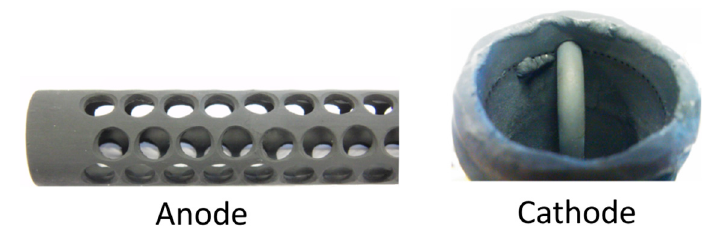
Figure 8. View of the anode and cathode elements after the lithiation process.